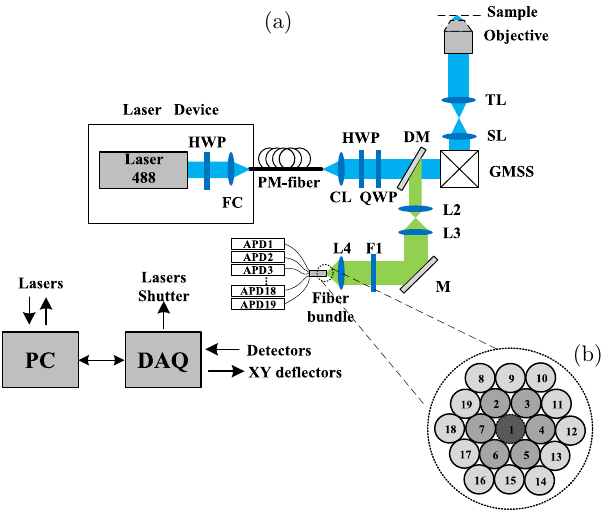
Fig. 1. Schematic of the experiment setup (a) and the ¯ber end of the tailor-made ¯ber bundle (b), which is made up of 19 isolated multi-mode ¯bers. FC, ¯ber collimator; PM-¯ber, po- larization maintaining ¯ber; CL, collimator; HWP, half wave plate; QWP, quarter wave plate; DM; dichromatic mirror; GMSS, galva mirror scan system; M, mirror; SL: scan lens, TL: tube lens, F: